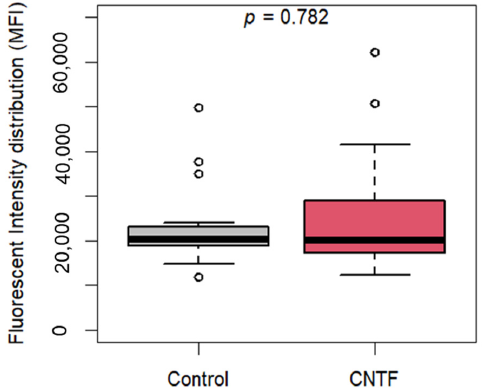
Figure 6. Glucose uptake after rhCNTF treatment of 22Rv1 cells. Boxplots show no differences in fluorescent intensity distribution (M.F.I.) between treated (median 20271, IQR 17416-28688) and untreated (median 20364, IQR 18784-23100) 22Rv1 cells with 10 ng/mL hrCNTF for 24 h. Interestingly, the distribution of the number of invaded cells is significantly ( p < 0.001) lower in the cells treated with 10 ng/mL CNTF (median 89; IQR 71-98) compared to untreated cells (median 208; IQR 149-247) (Figure 7).